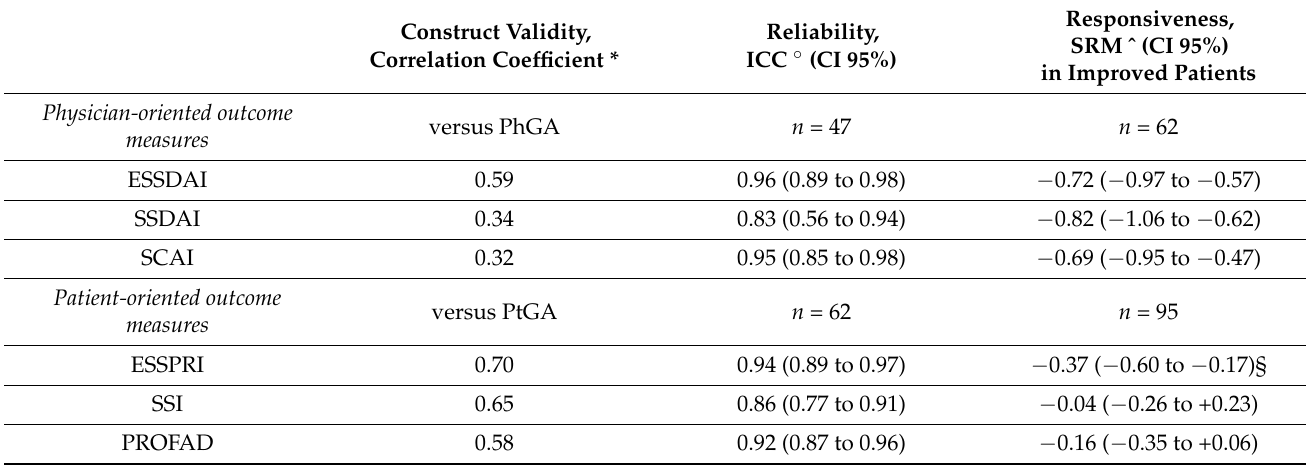
Table 1. Construct validity, reliability, and sensitivity to change (responsiveness) of the main outcome measures used for the assessment of patients with pSS